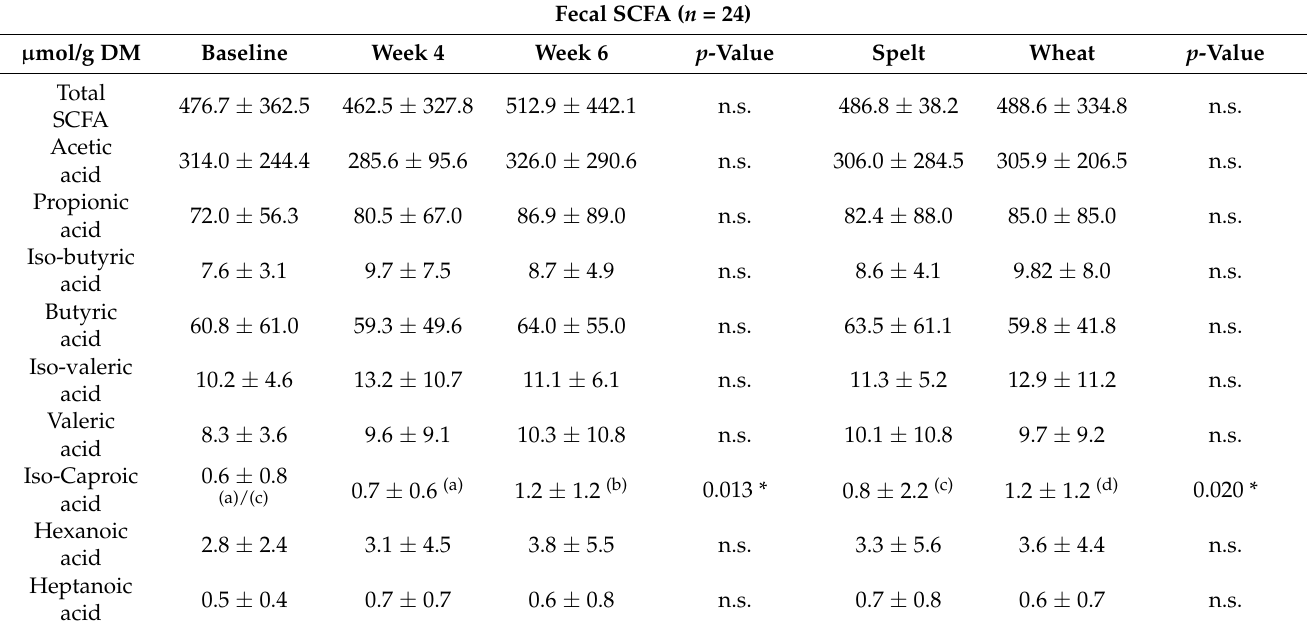
Table 4. Concentration of short-chain fatty acids (SCFA) per dry mass in fecal samples at baseline, after week 4 and week 6 as well as after consumption of two weeks spelt bread (spelt) and after two weeks wheat bread